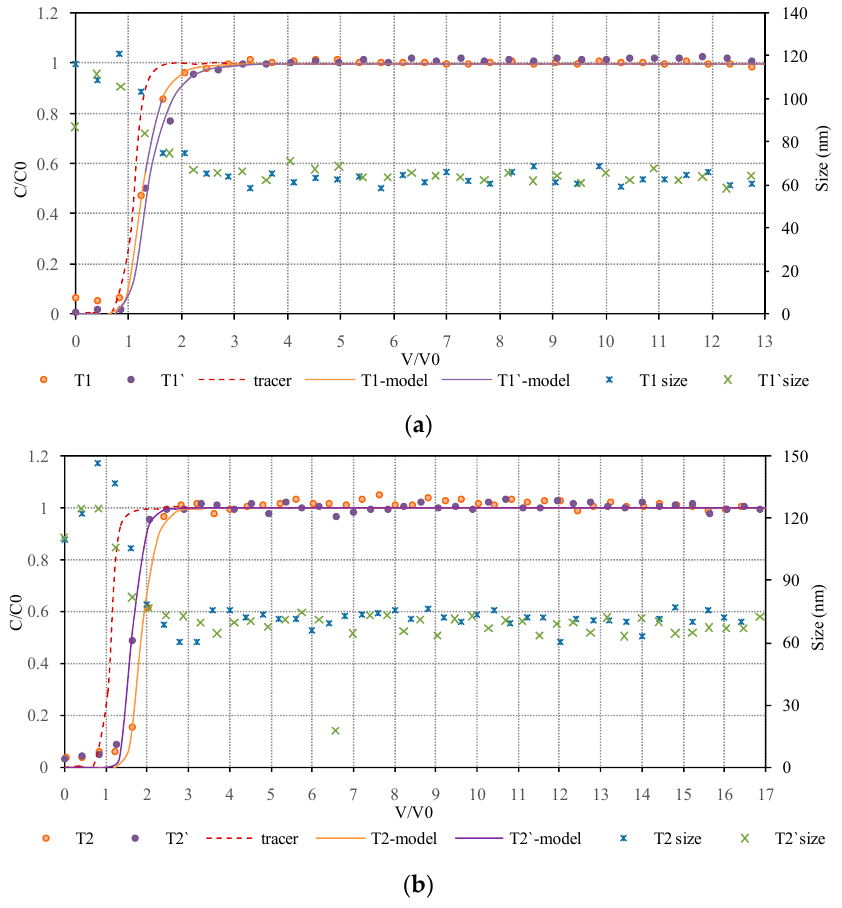
Figure 5. Experimental breakthrough curves for colloidal silica with and without HA in: ( a ) deionized water; ( b ) monovalent ion solution.